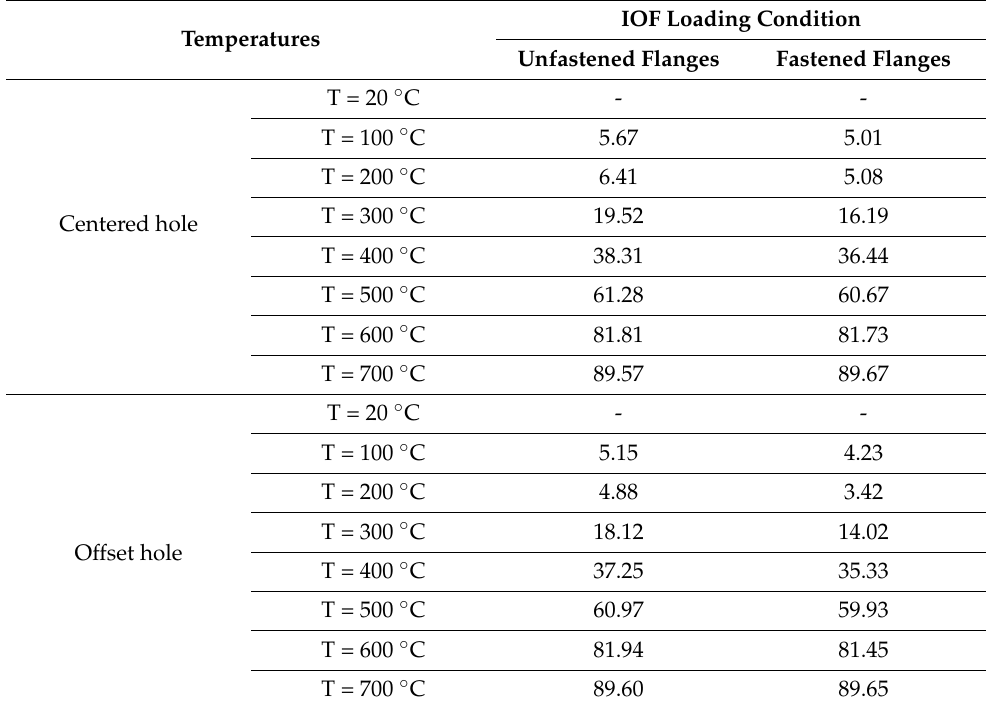
Table 4. Average web crippling strength reduction percentage (%) of investigated sections at elevated temperatures against ambient temperatures ( T = 20 ◦ C). Temperatures